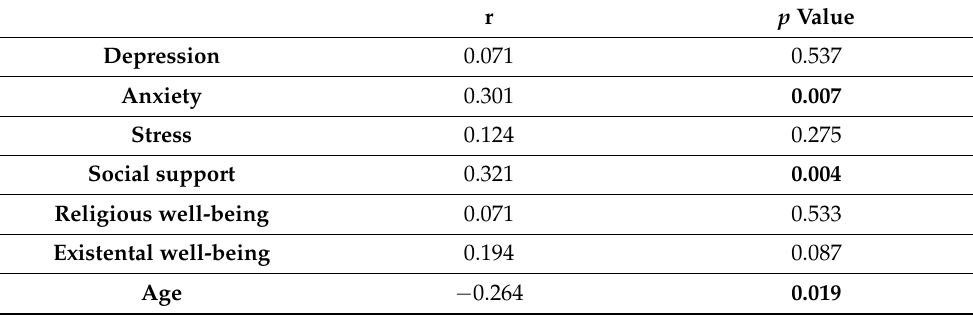
Table 4. Pearson correlation between PTGI total scores and other continuous variables ( n = 79).